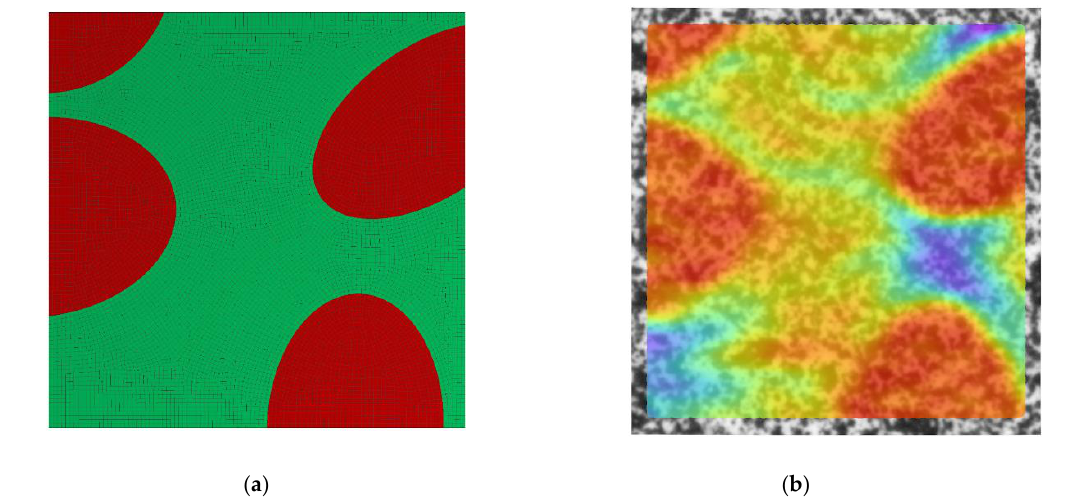
Figure 6. Fragment of the speckle pattern that was tested.